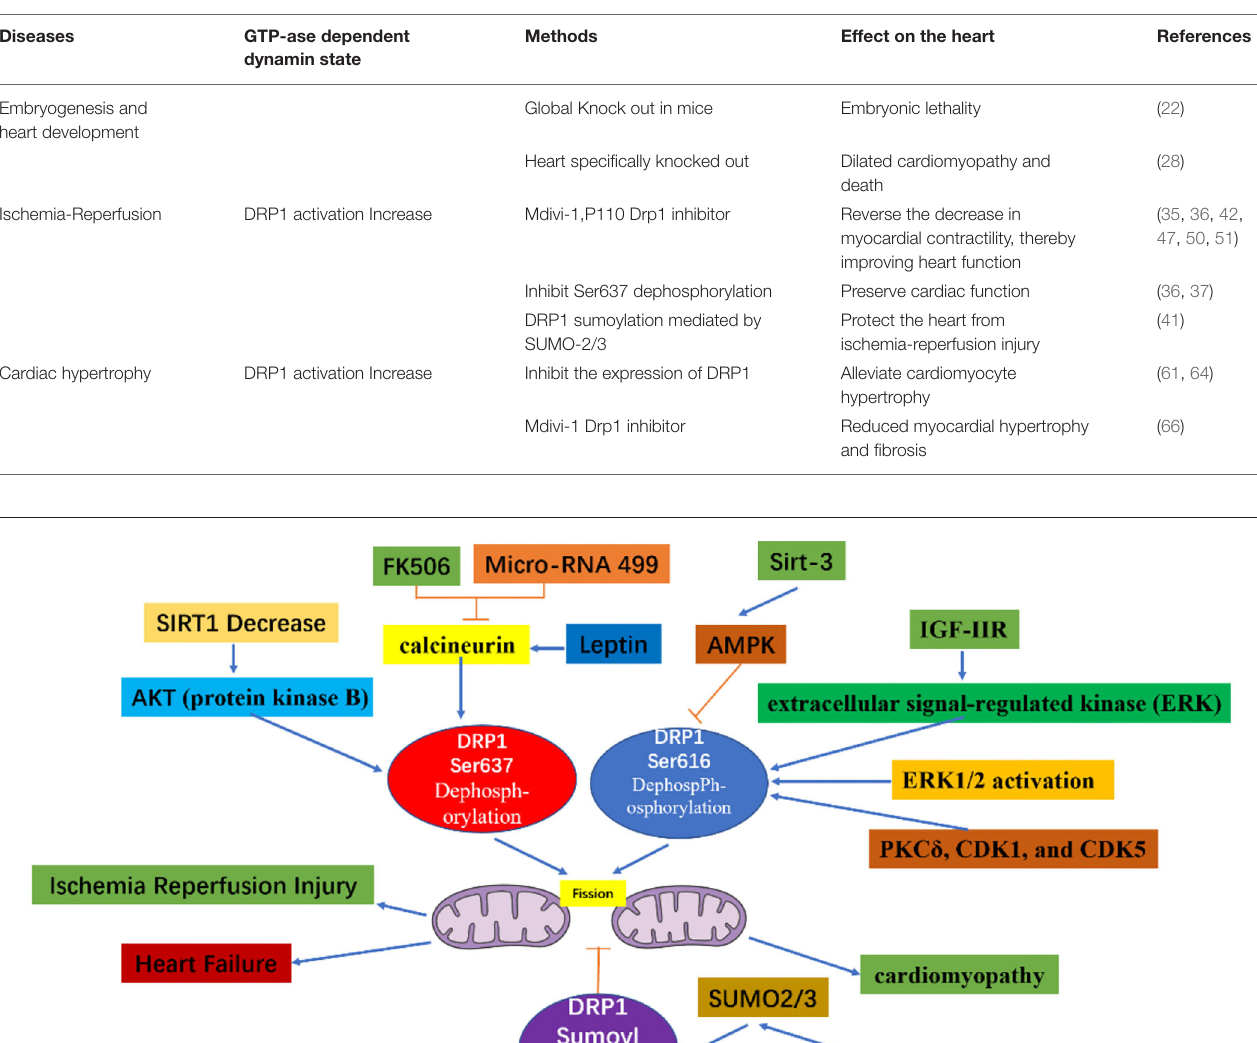
TABLE 1 | Drp1 the role of Drp1 in heart development and heart disease.